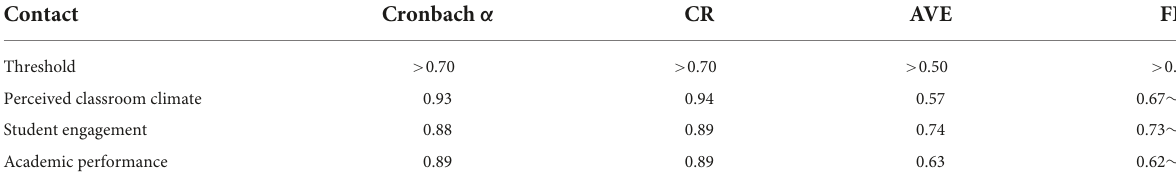
TABLE 1 Analysis of validity and reliability.